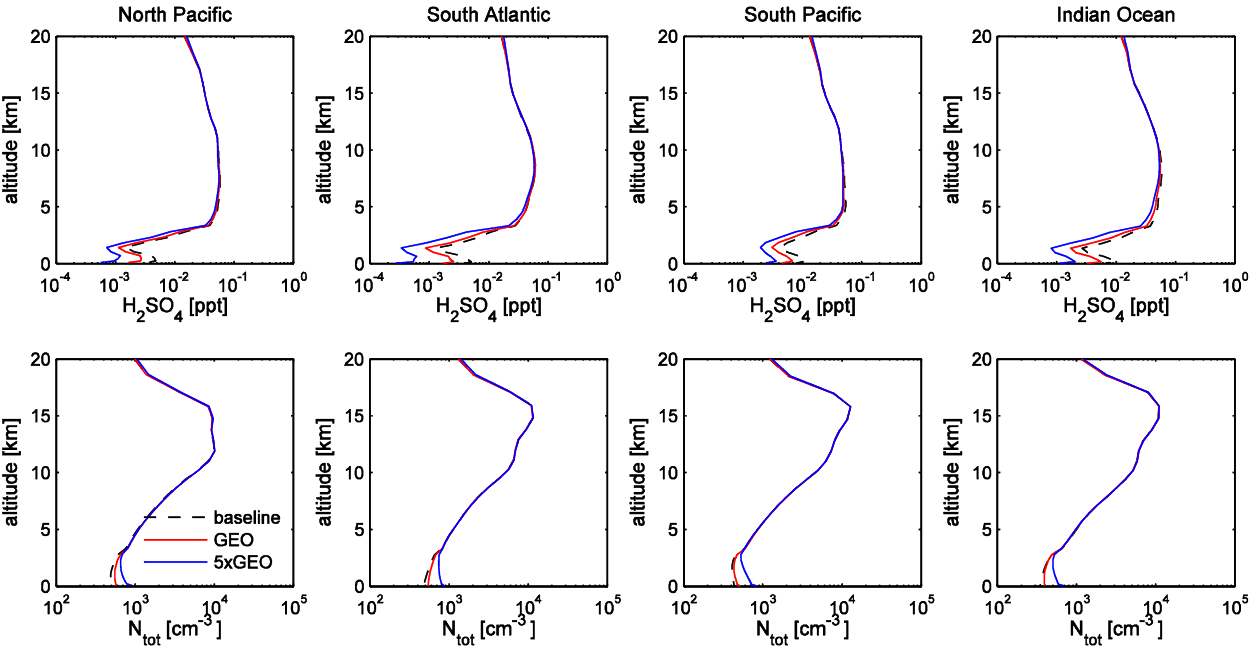
Fig. 8. Effect of cloud seeding on the annual mean vertical profiles of H 2 SO 4 (top panels) and total particle number concentration (N tot ) in the four geoengineered Figure 8: Effect of cloud seeding on the annual mean vertical profiles of H and total particle number concentration (N